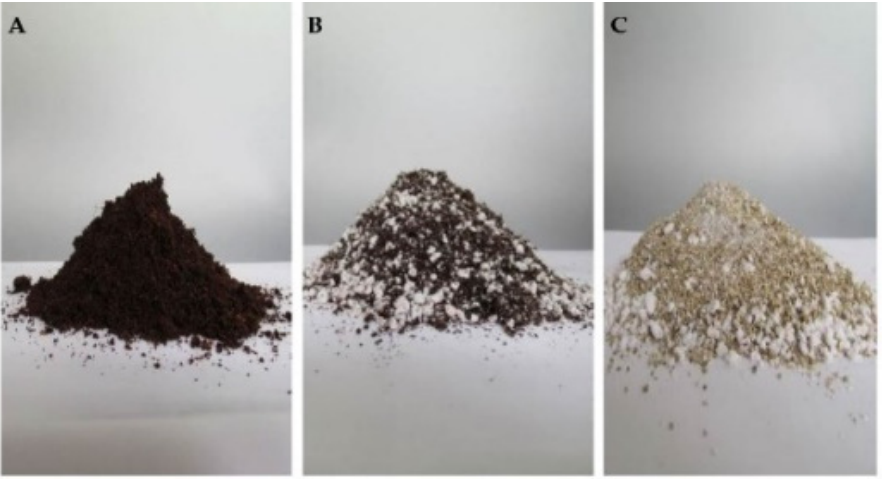
Figure 3. Substrates: ( A ) coconut fibers (100%, C); ( B ) coconut fibers (70%) + perlite (30%) (CP); ( C ) perlite (50%) + vermiculite (50%) (PV).